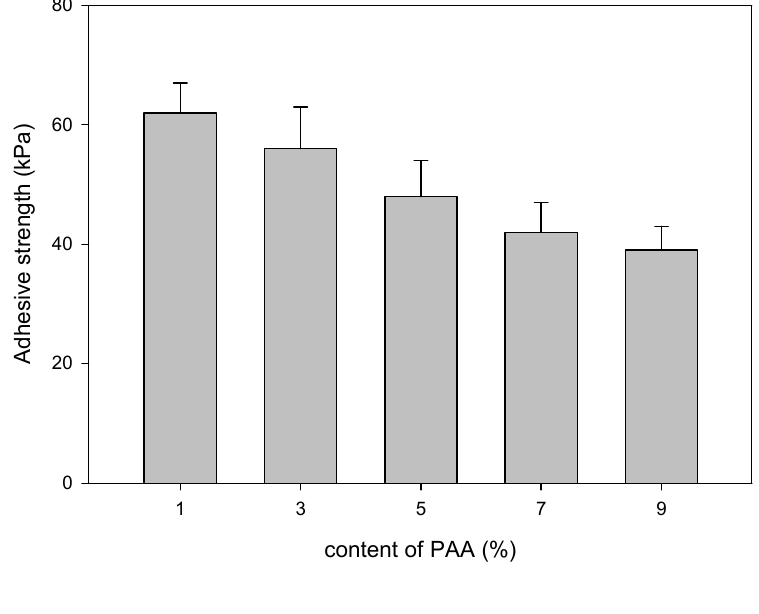
Figure 4. Effect of irradiation dose on the mucoadhesive